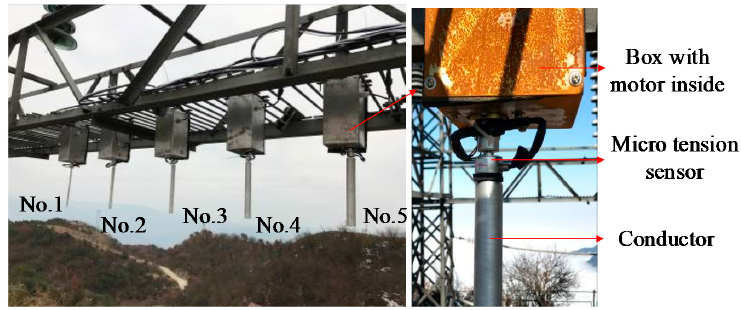
Figure 6. Rotating multi-cylinders (RMCs) used for monitoring climate parameters.